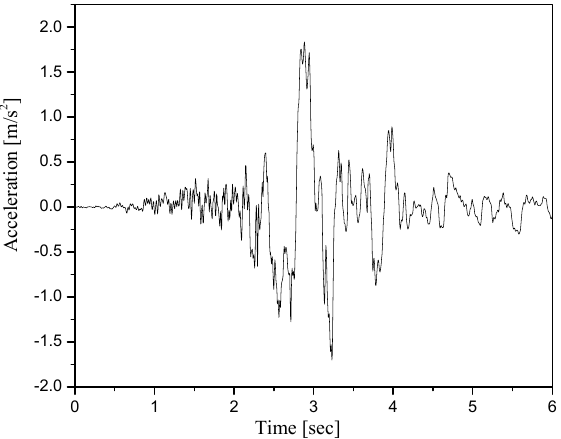
Figure 1: Acceleration history of near-fault ground motion is applied in the numerical simulation